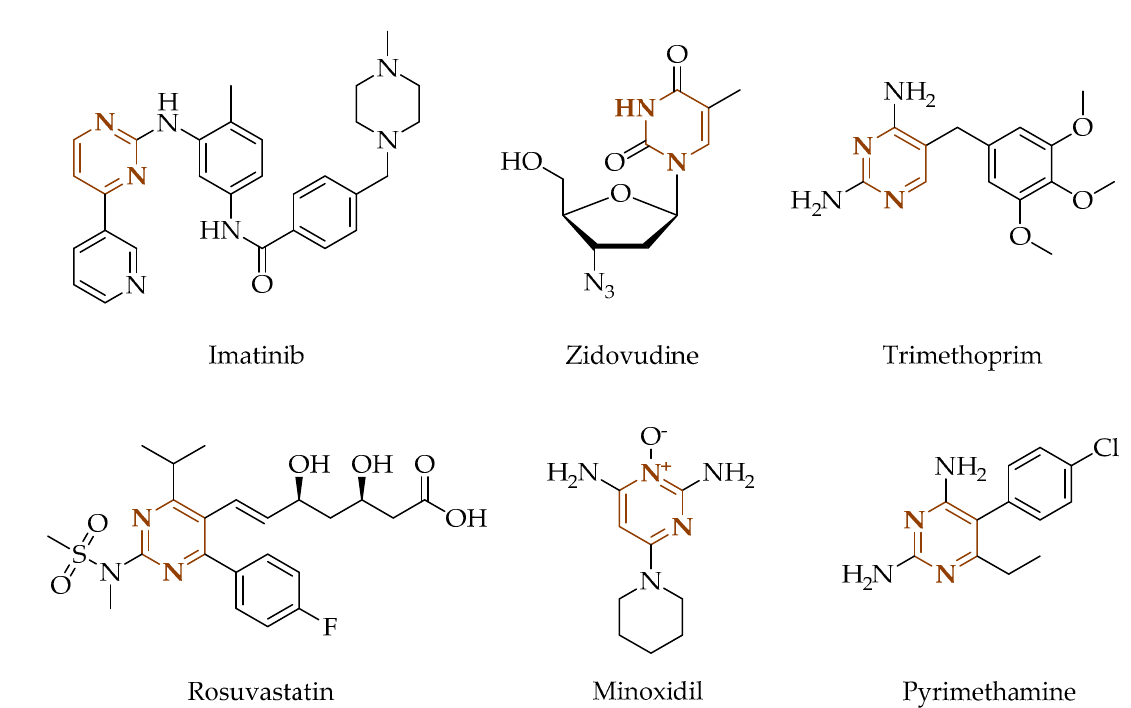
Figure 1. Representative drugs with pyrimidine moiety on the market: anticancer (e.g., imatinib [6]), antiviral (e.g., zidovudine [7]), antibacterial (e.g., trimethoprim [8]), antihyperlipidemic (e.g., rosuvastatin [9,27]), antihypertensive (e.g., minoxidil), and antimalarial (e.g., pyrimethamine).